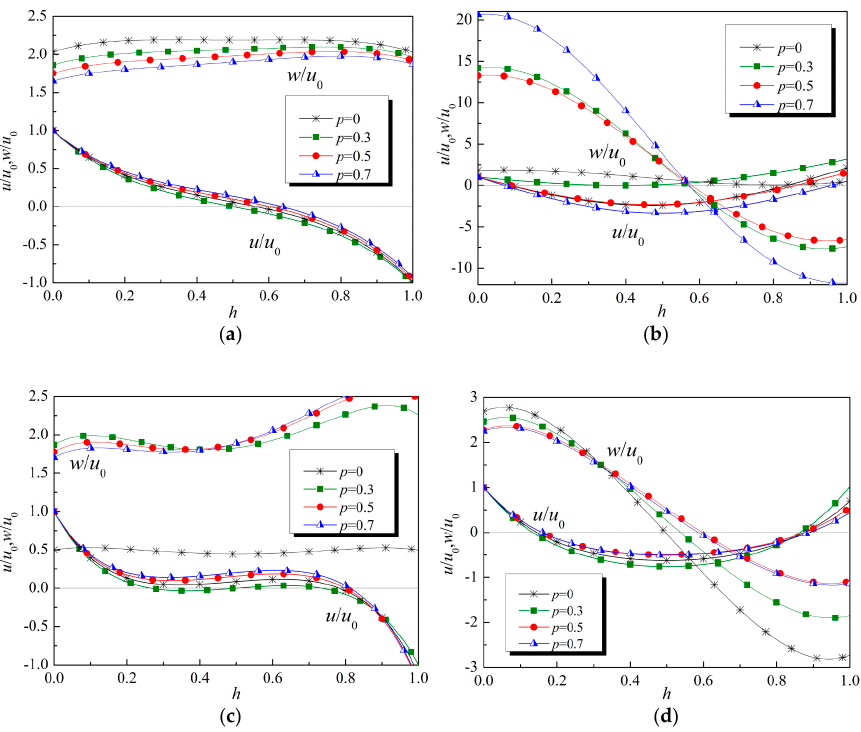
Figure 7. Wave structure of Lamb waves (with all material parameters varying linearly and identically). ( a ) kh = π , Mode 1, ( b ) kh = π , Mode 2, ( c ) kh = 2 π , Mode 1, ( d ) kh = 2 π , Mode 2.